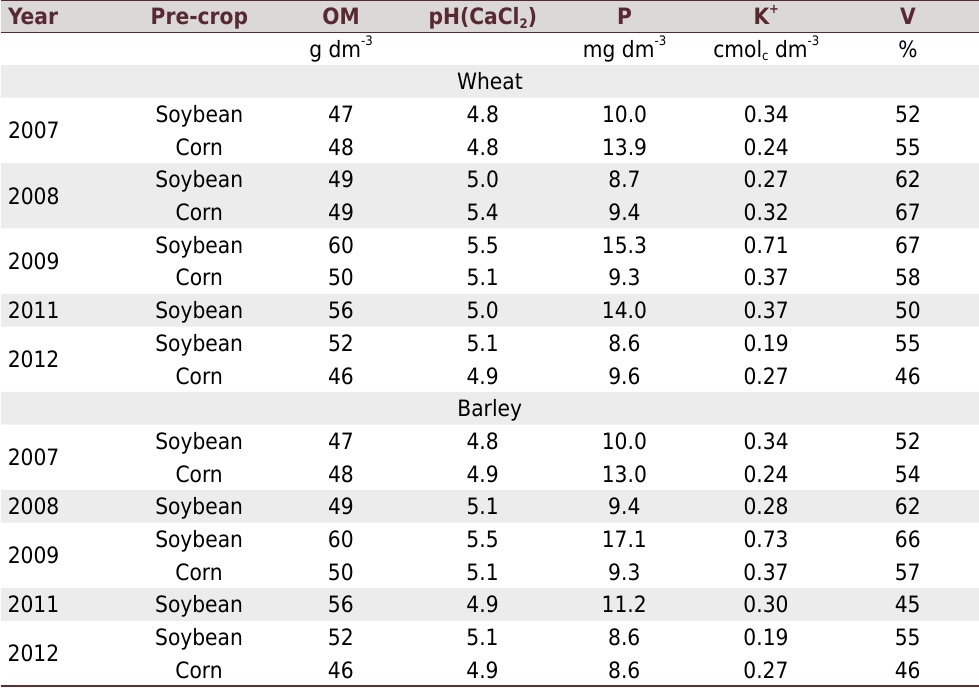
Table 2. Chemical properties of the soils where the nitrogen fertilization experiments with winter cereal crops were conducted in the South-Central region of Paraná Year Pre-crop